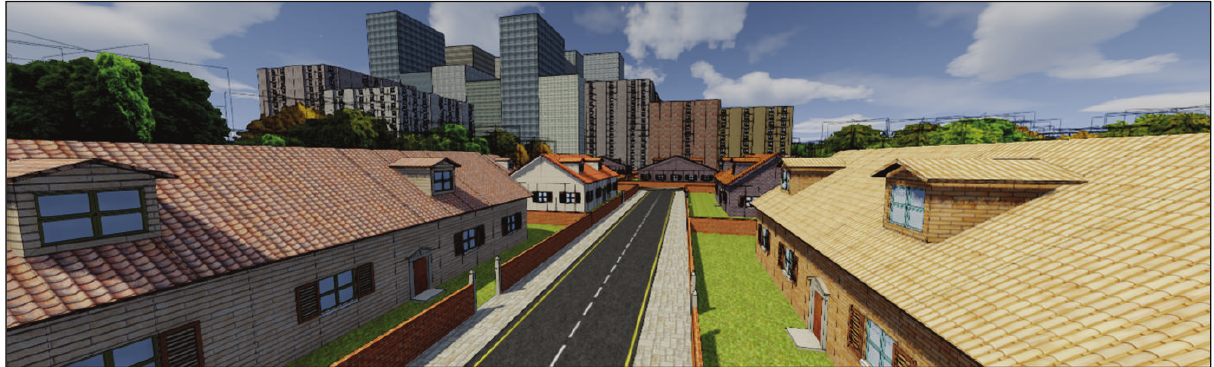
Figure 12: Detailed, close-up view on the city from Figure 7.